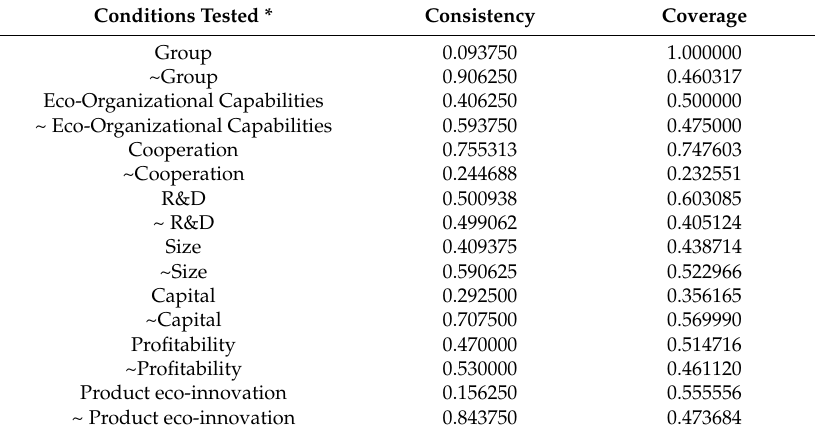
Table 5. Companies developing internal process innovations. Analysis of the necessary